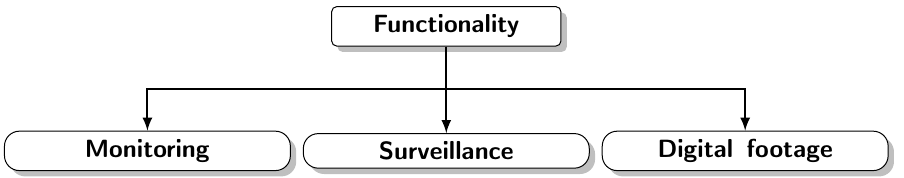
Figure 3. Taxonomy for the functionality of observation